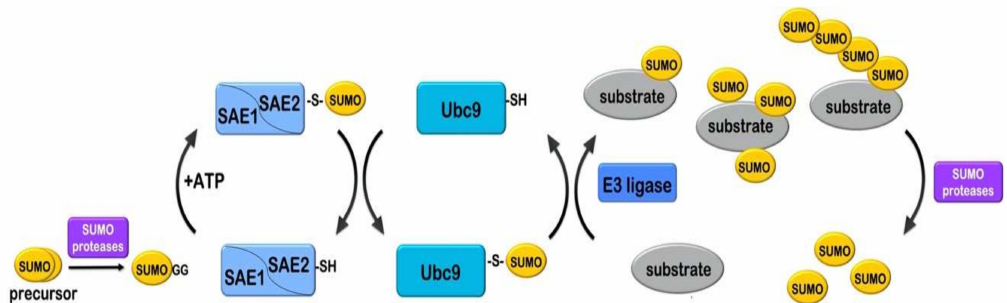
Figure 1. The SUMO conjugation mechanism. Initially the SUMO precursor form is proteolytically cleaved (by SUMO-specific proteases) to expose the C-terminal glycine–glycine (GG) motif. Mature SUMO is activated by the SUMO E1 heterodimer SAE1 / SAE2 (Aos1 / Uba2) in an ATP-dependent manner, then a thioester bond is formed between the C-terminal glycine of SUMO and the catalytic cysteine (-SH) of SAE2. SUMO is subsequently loaded to the catalytic cysteine of the SUMO E2 enzyme Ubc9. Ubc9 catalyzes formation of an isopeptide bond between the C-terminal glycine of SUMO and a lysine residue in the substrate. This procedure is usually facilitated by a SUMO E3 ligase. Sumoylation can occur as mono-sumoylation, poly-mono-sumoylation or polysumoylation (formation of sumo chains) on target substrates. Sumoylation is reversed by SUMO-specific proteases that cleave the isopeptide bond and release